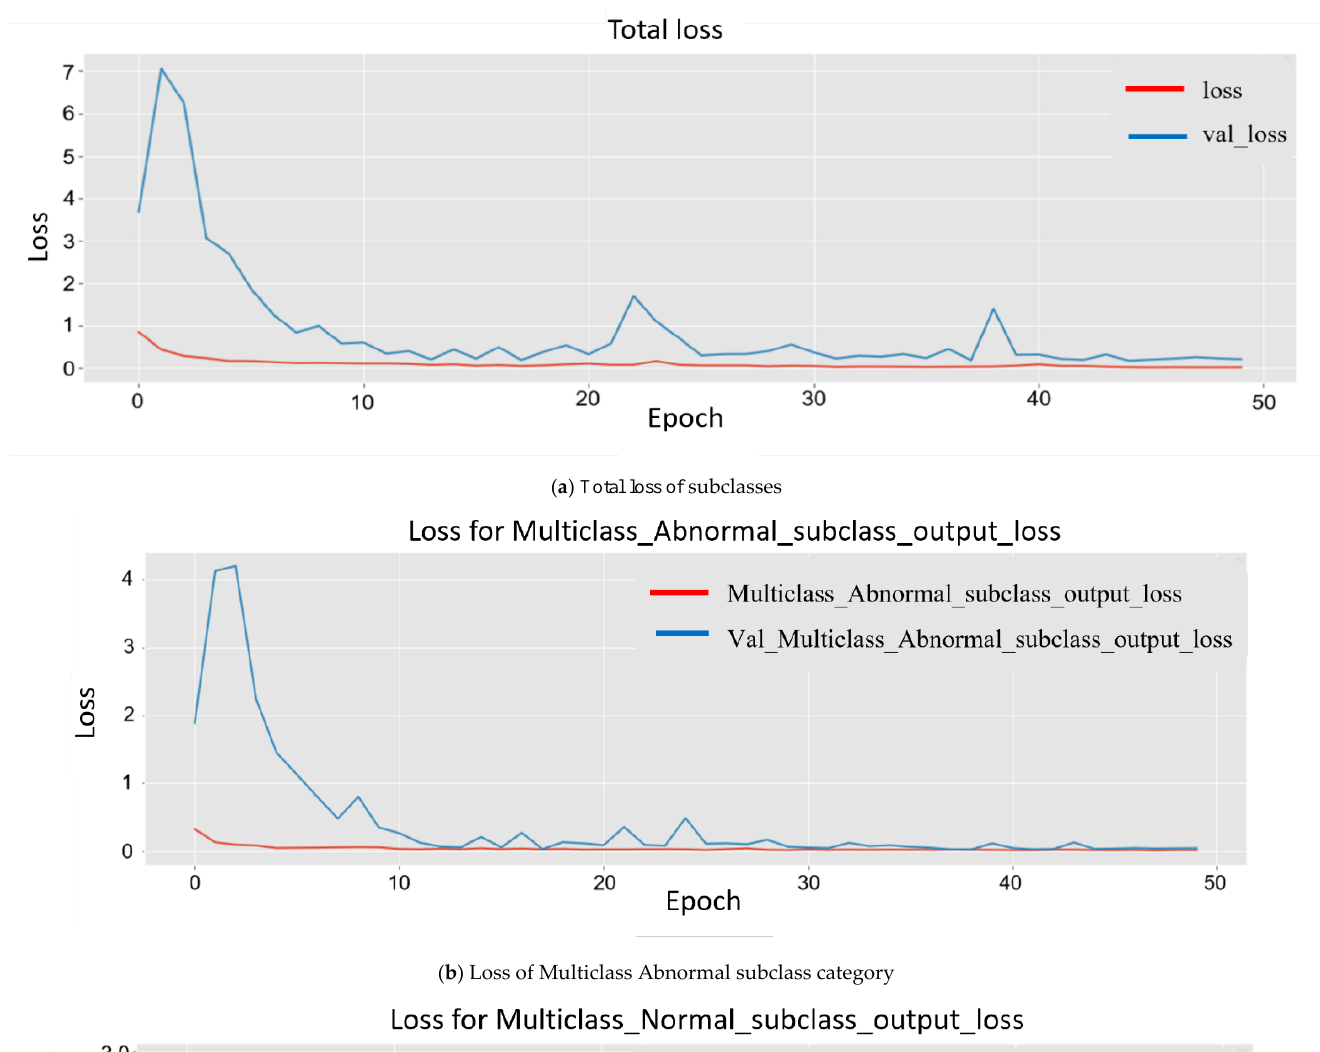
Figure 8. Two separate experimental plots show the accuracy in order to analyze the training.